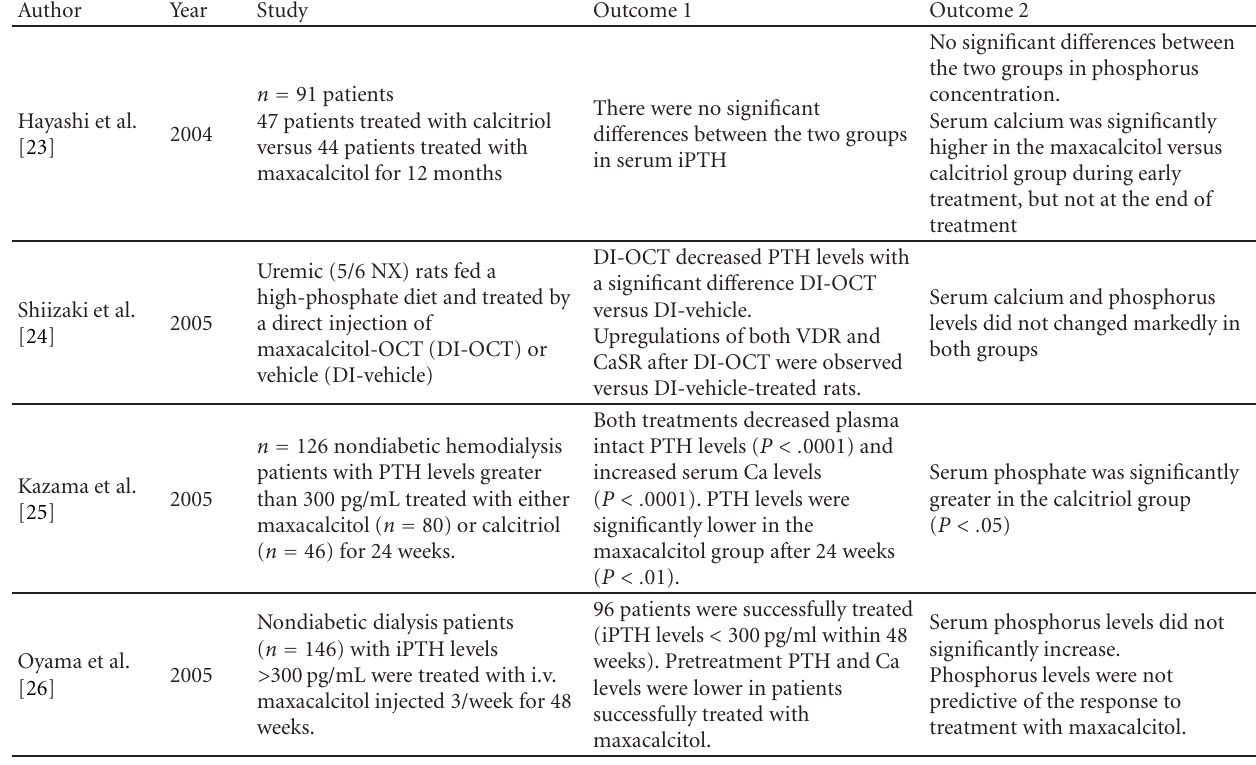
Table 4: Suppression of PTH and e ff ects on calcium and phosphate levels: maxacalcitol versus placebo and maxacalcitol versus calcitriol.